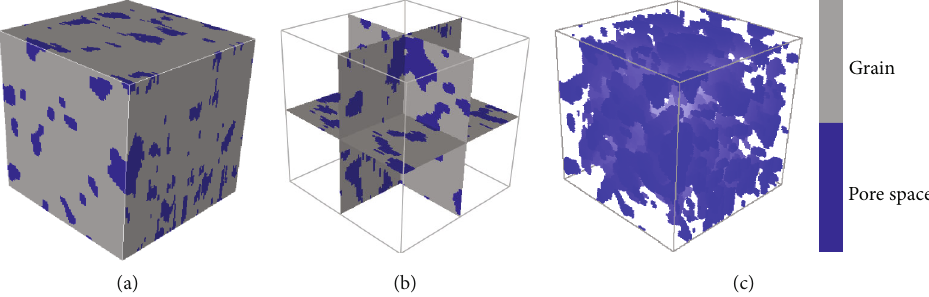
Figure 10: The TI of sandstone: (a) exterior; (b) cross-section ( X = 40 , Y = 40 , and Z = 40 ); (c) pore space.